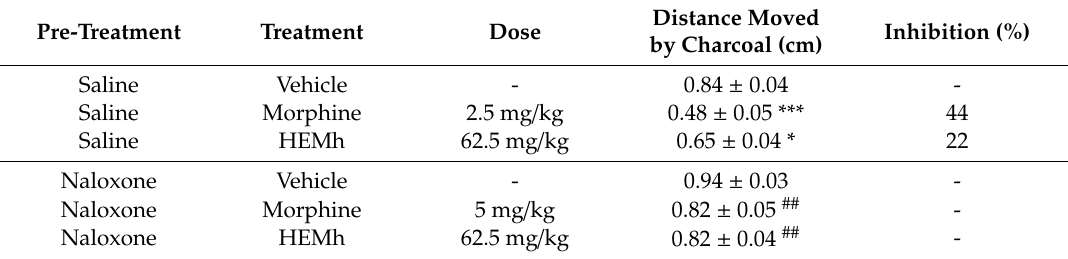
Table 5. Effects of hydroalcoholic extract from the twigs of Machaerium hirtum (HEMh) on intestinal propulsion in mice with naloxone (opioid receptor antagonist).